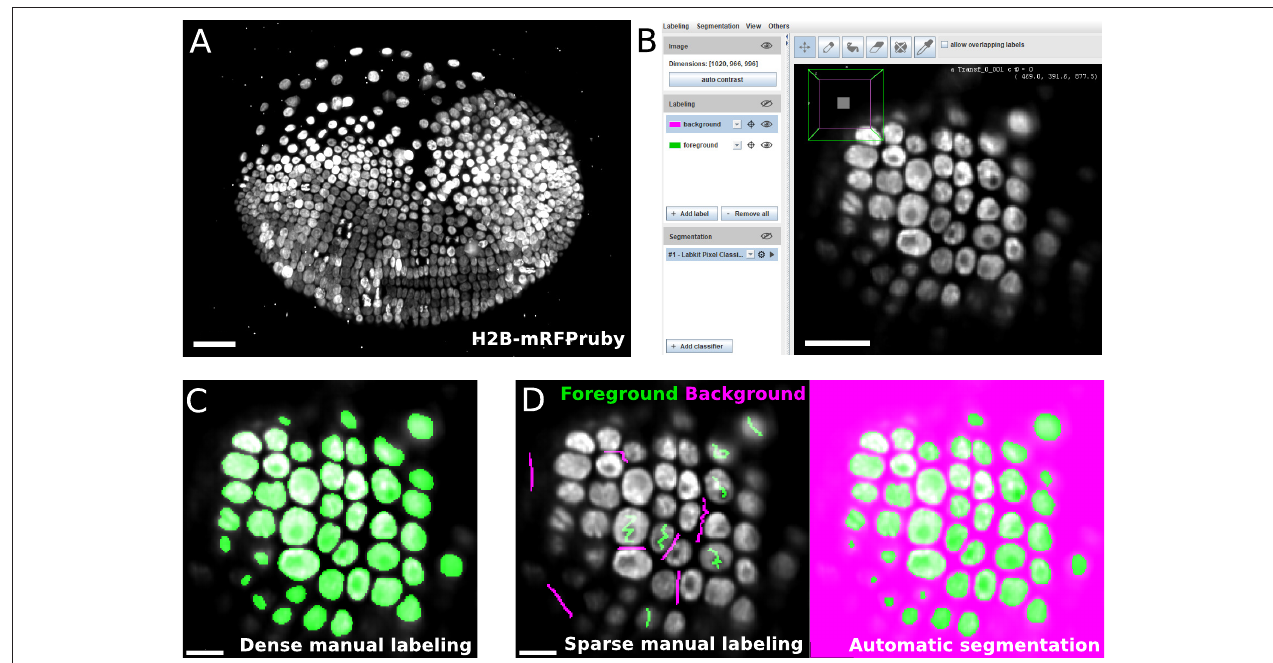
FIGURE 1 | LABKIT allows easy manual labeling and automatic segmentation of large image volumes: (A) Maximum intensity projection of a single time point from a ∼ 1 TB timelapse of a developing Parhyale embryo imaged live with lightsheet microscopy. (B) LABKIT ’s user interface is based on BigDataViewer and allows visualizing and interacting with large volumes of image data. A slice of the developing Parhyale embryo is shown. (C) Users can label large datasets with dense manual annotations using LABKIT ’s drawing interface. (D) A core feature of LABKIT is the rapid segmentation of large image data using sparse manual labels (scribbles) combined with random forest pixel classification to automatically produce the final segmentation. Scale bars 100 µ m (A) , 50 µ m (B) , and 25 µ m (C,D)